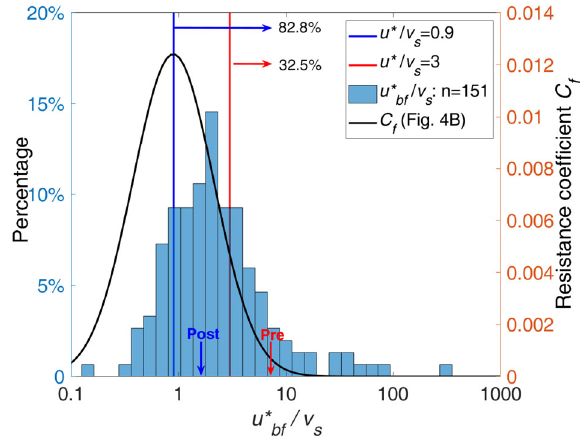
Fig. 6 Distribution of bankfull suspension numbers for fi ne-grained rivers worldwide. The vertical blue solid line represents the suspension number corresponding to the maximum resistance coef fi cient/dune size, obtained in the present study. This shows that 82.8% of fi ne-grained rivers maintain a bankfull suspension number greater than 0.9, indicating that for the majority of fi ne-grained rivers worldwide, bed coarsening will enhance dune size and thus fl ow resistance, so as to amplify fl ood stage. The vertical red solid line represents the suspension number (3.0) corresponding to borderline of silt-sand-bedded rivers (32.5% of fi ne-grained rivers worldwide), such as the Yellow River, where a bed coarsening process can act far more quickly over a short time scale, indicating a quick and strong fl ood ampli fi cation effect. Arrows on the x-axis indicate pre- and post- damming conditions of the lower Yellow